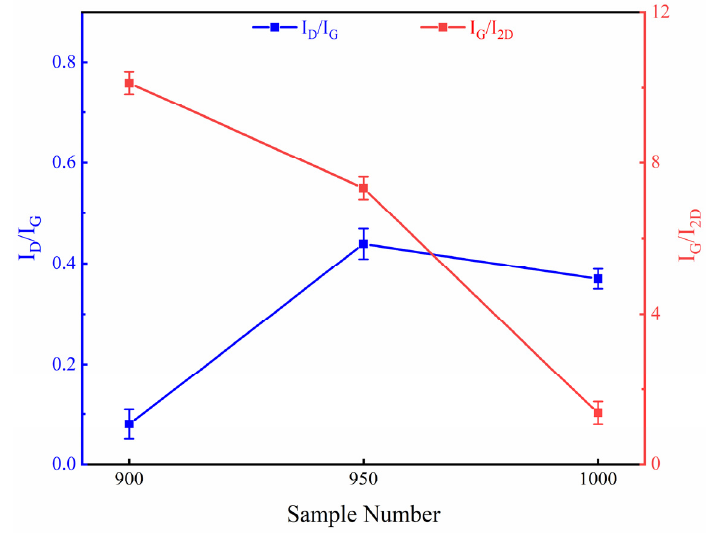
Figure 6. The I D / I G , I G / I 2 D value at different growth temperatures.